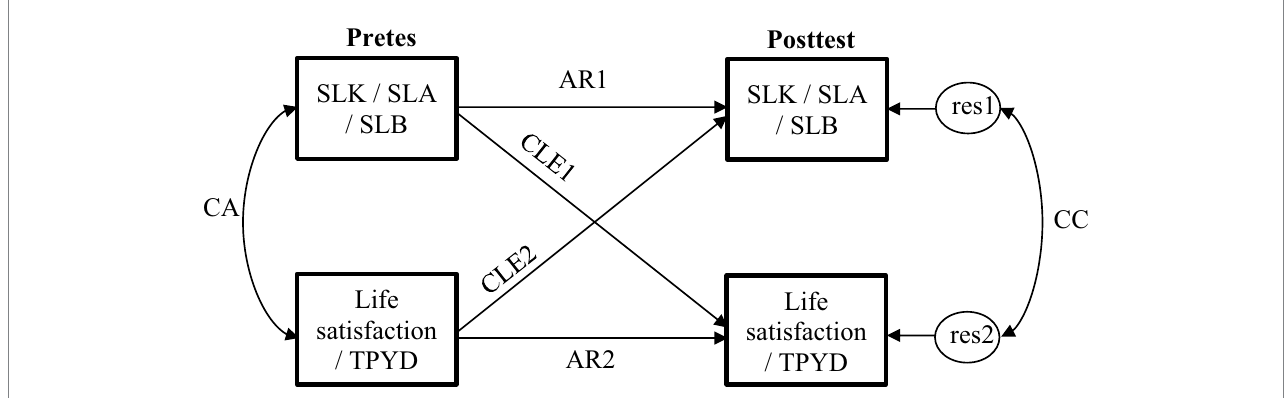
FIGURE 1 Cross-lagged path analyses of the relationships between service leadership attributes and well-being indicators. SLK, service leadership knowledge; SLA, service leadership attitude; SLB, service leadership behavior; TPYD, total positive youth development score; res, residual; CA, concurrent association; AR1, autoregression of service leadership attributes; AR2, autoregression of well-being indicator; CLE1, cross-lagged effect of service leadership attributes on well-being indicator; CLE2, cross-lagged effect of well-being indicator on service leadership attributes; and CC, correlated change.